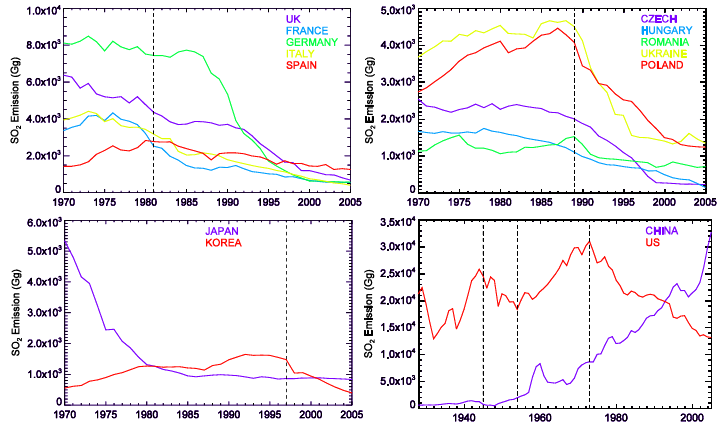
Figure A3. SO 2 emission for several major countries. Data are from S. J. Smith et al. (2011a). The top left and top right panels include major countries of western and eastern Europe, respectively. Vertical lines represent division years of the study periods that roughly indicate transition points of emission trend.